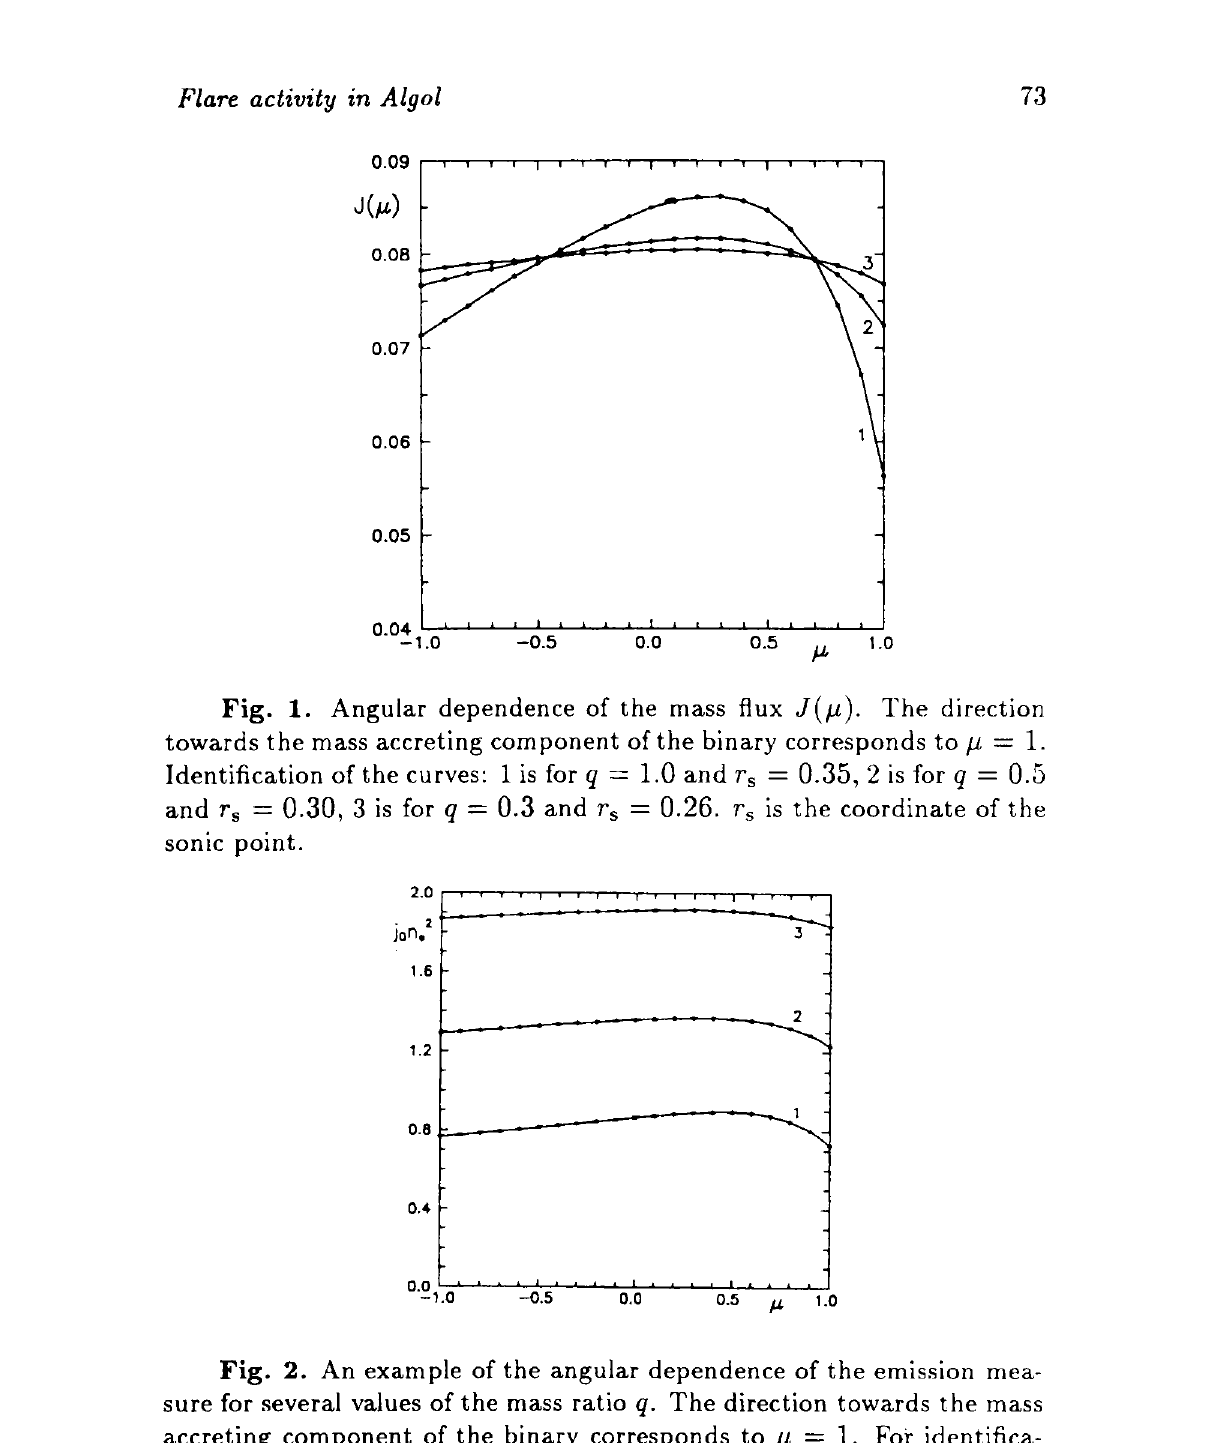
Fig. 2. An example of the angular dependence of the emission mea- sure for several values of the mass ratio q. The direction towards the mass accreting component of the binary corresponds to fi = 1. For identifica- tion of the curves see Fig.